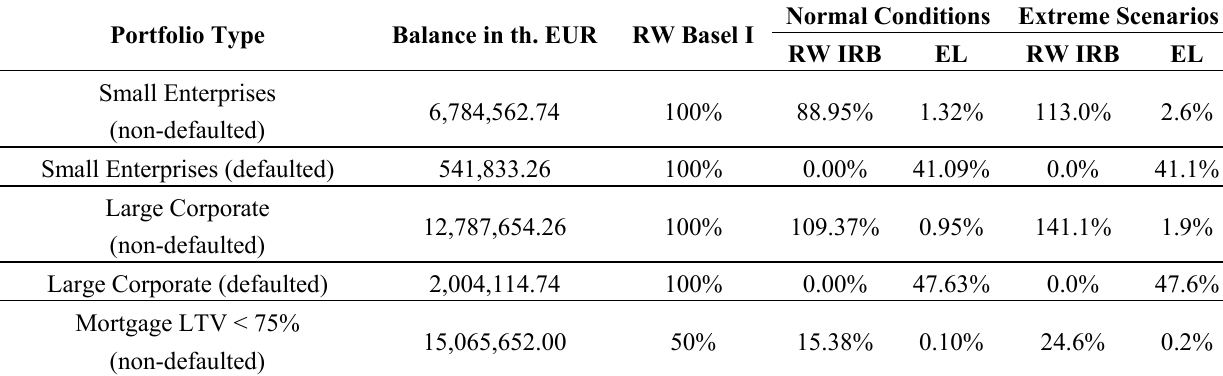
Table 4. Bank 2: RW analysis per portfolio for normal and extreme